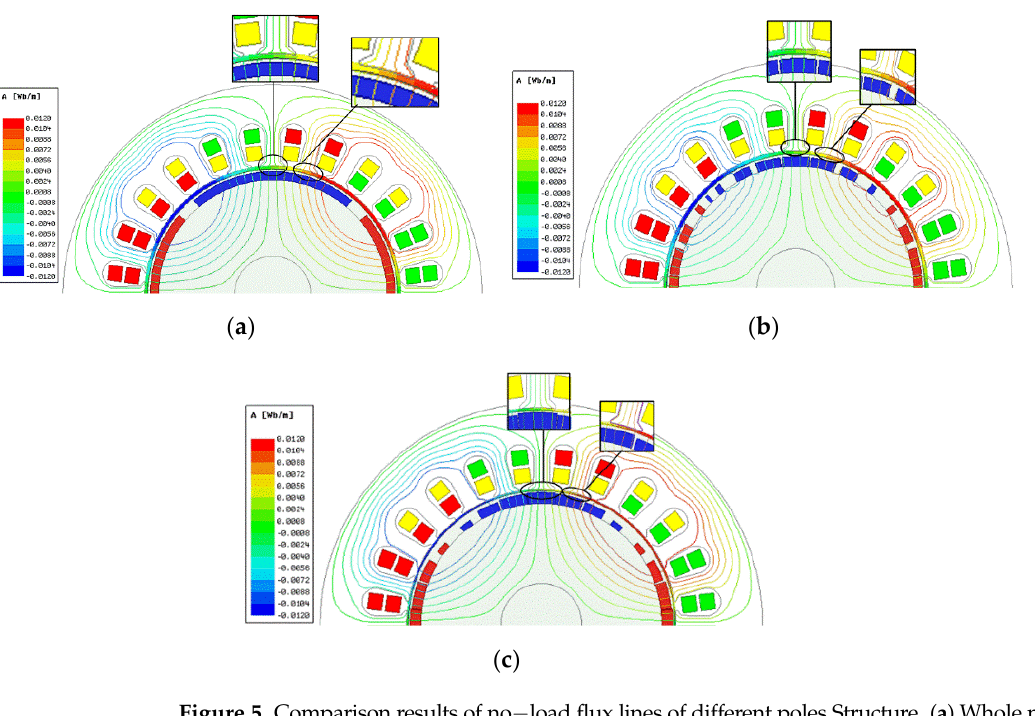
Figure 5. Comparison results of no−load flux lines of different poles Structure. ( a ) Whole magnetic pole. ( b ) Equal amplitude modulated pole. ( c ) Unequal amplitude modulated pole.